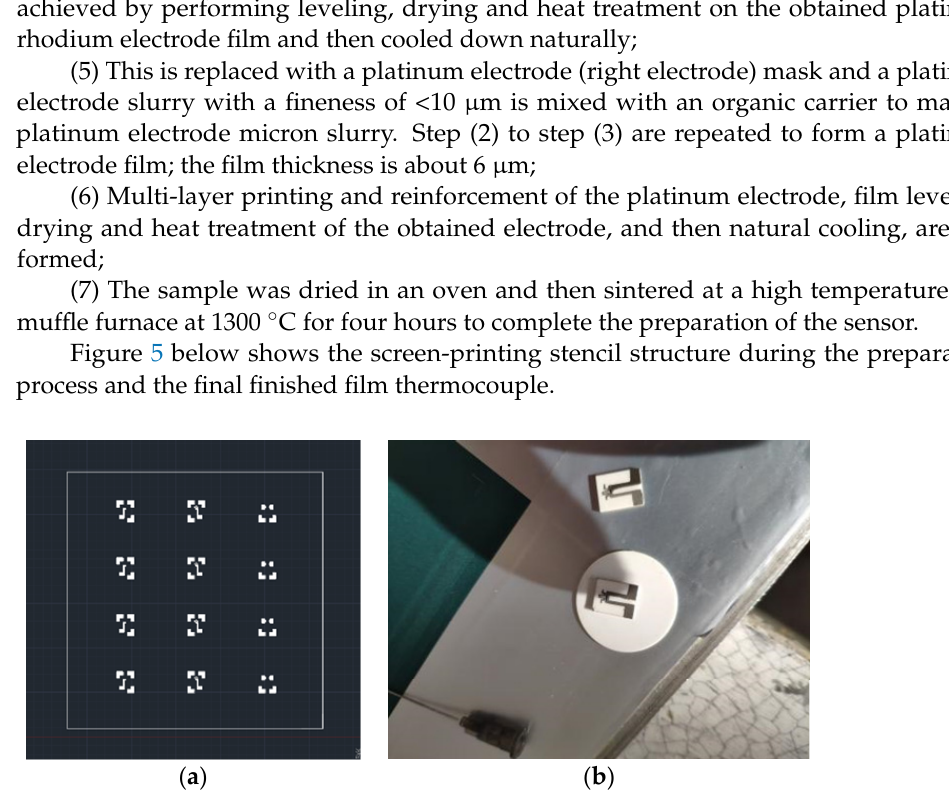
Figure 5. Screen-printing screen structure during preparation and final thin-film thermocouple products: ( a ) Screen-printing screen structure; ( b ) The thermocouple sample has been made. In the screen-printing manufacturing process, sintering is a very important process.